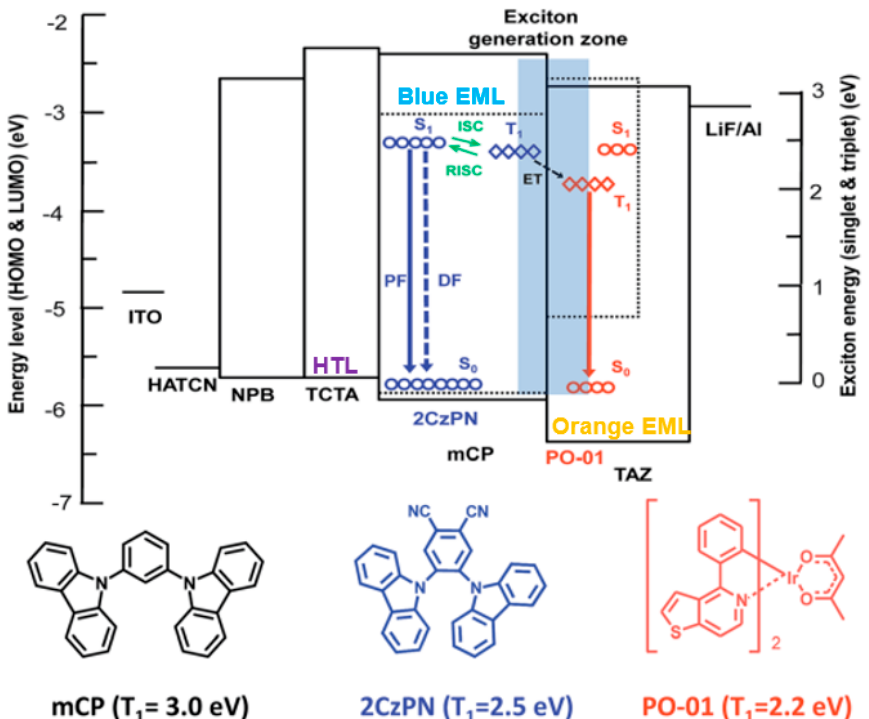
Figure 25. The function mechanism. PF and DF denote prompt and delayed fluorescence, respectively. ET is energy transfer. Reproduced from Reference [215] with permission from the Royal Society of Chemistry.